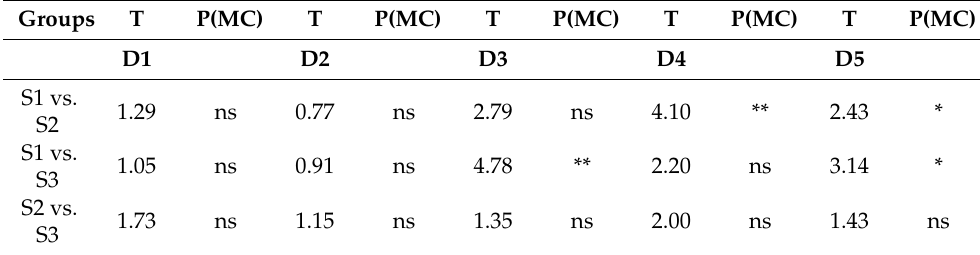
Table 6. Results of the pairwise tests contrasting the prey compositions of polyps of the three spe-